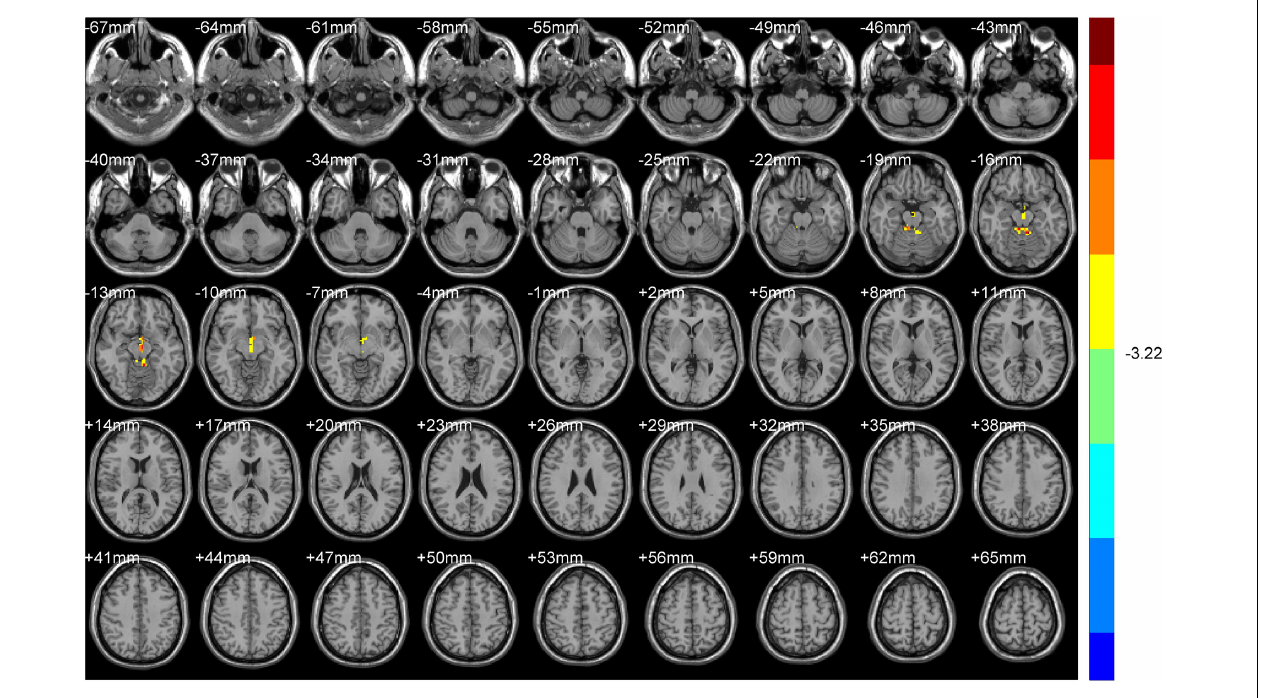
FIGURE 2 | ALFF (Dominant hemisphere vs.